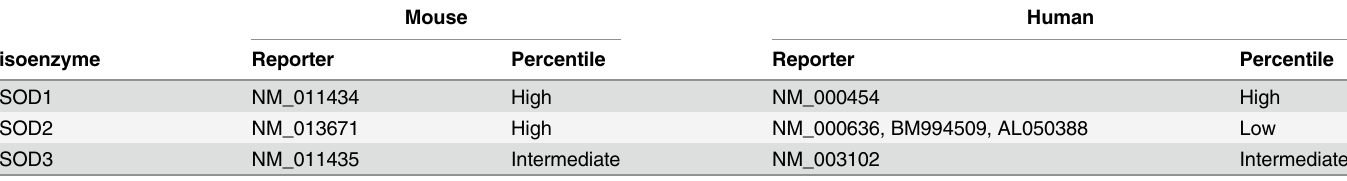
bound fatty acids and proteins. These are subsequently recognized by the body as non-self, and invoke a chronic, complement mediated, immune response [22,23].